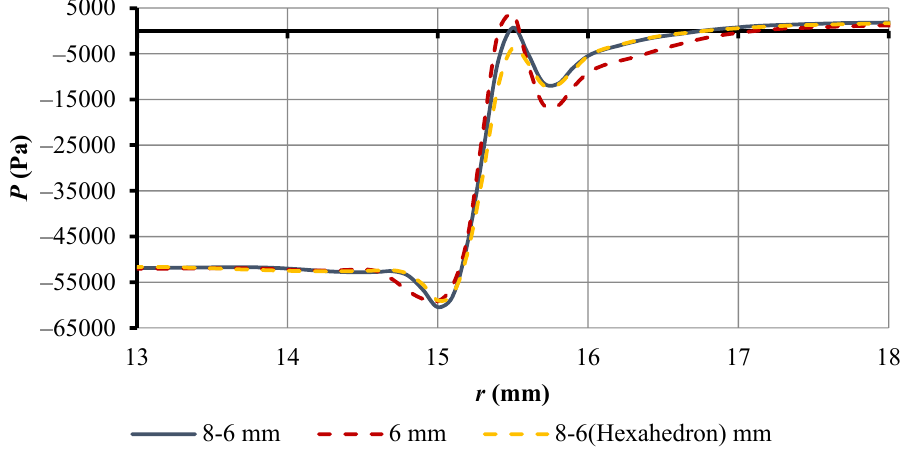
Figure 11. Dependence of air pressure distribution on the surface of an OM at different parameters of the geometry of the narrowing of the fitting.